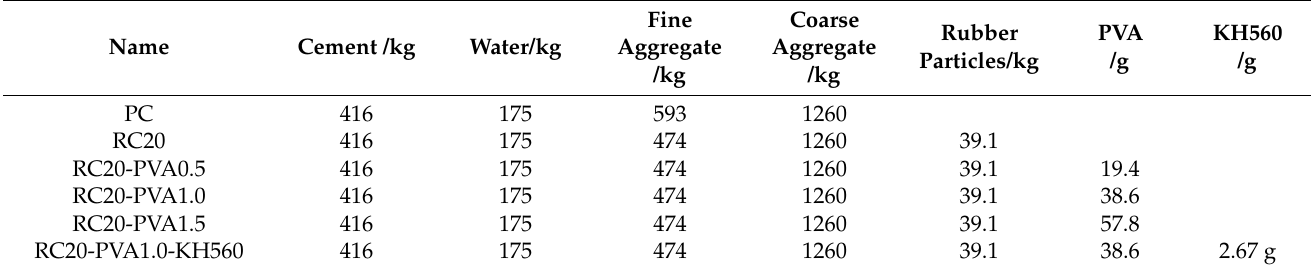
Table 5. Modified PVA fiber rubber concrete mix ratio.